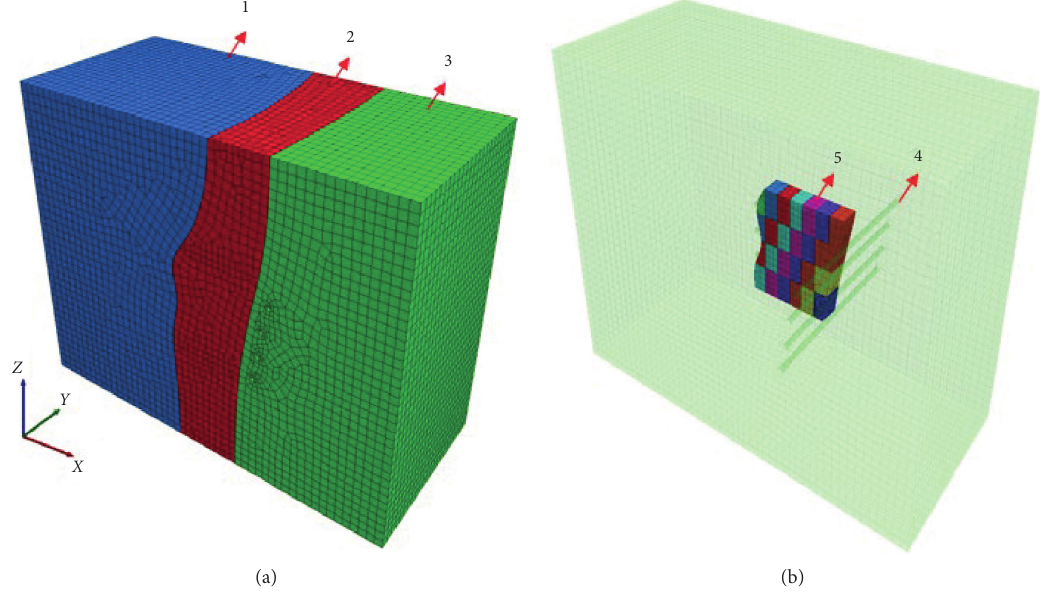
Figure 9: Calculation model: (1) hanging wall, (2) ore body, (3) lower wall, (4) retaining roadways along goaf, and (5) stope.